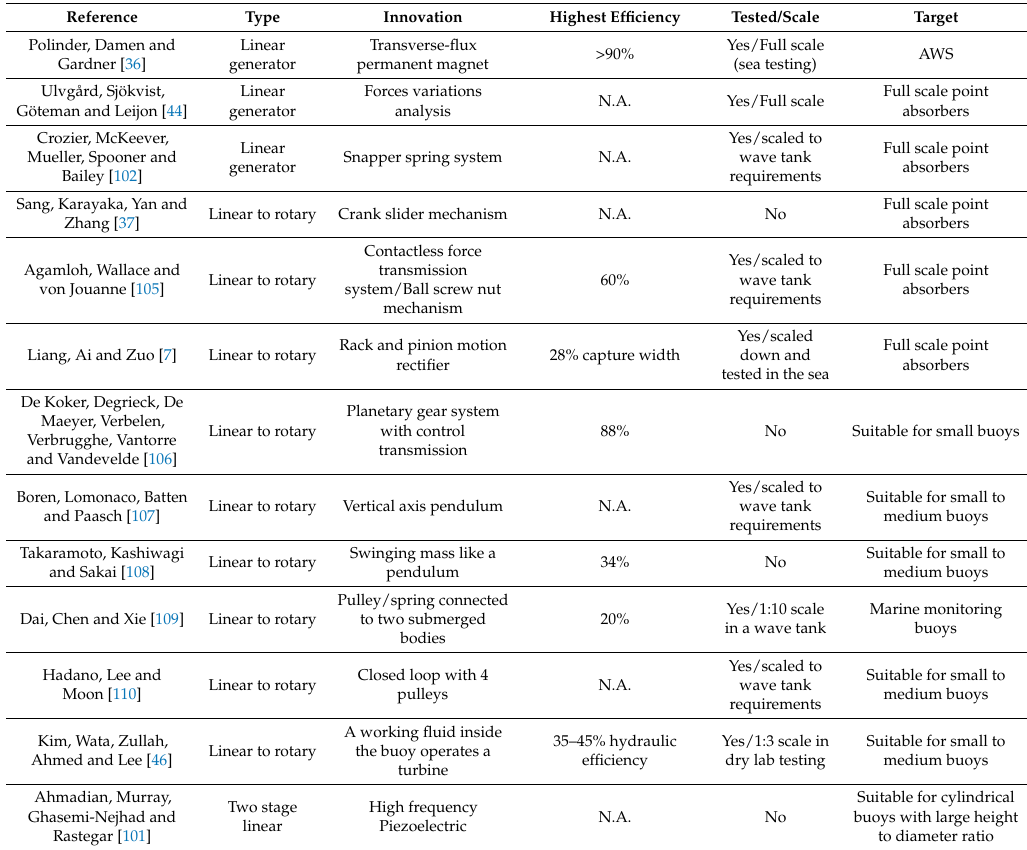
Table 1. Novel PTOs recently